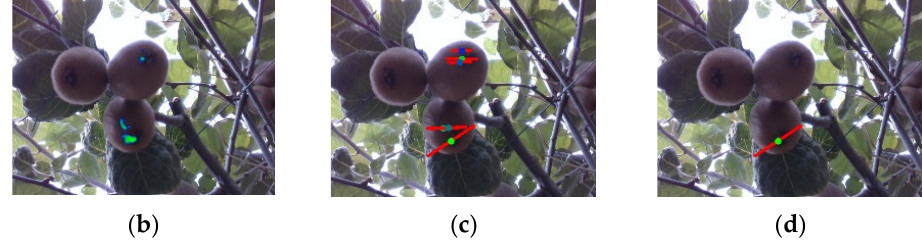
Figure 9. Detection process of the grasping angle: ( a ) depth image; ( b ) candidate grasping areas; ( c ) candidate grasping angles; ( d ) grasping angle.